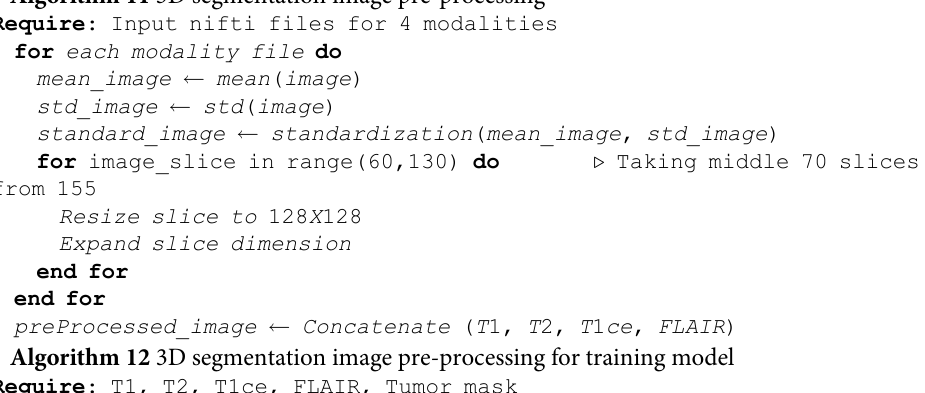
Algorithm 12 3D segmentation image pre-processing for training model